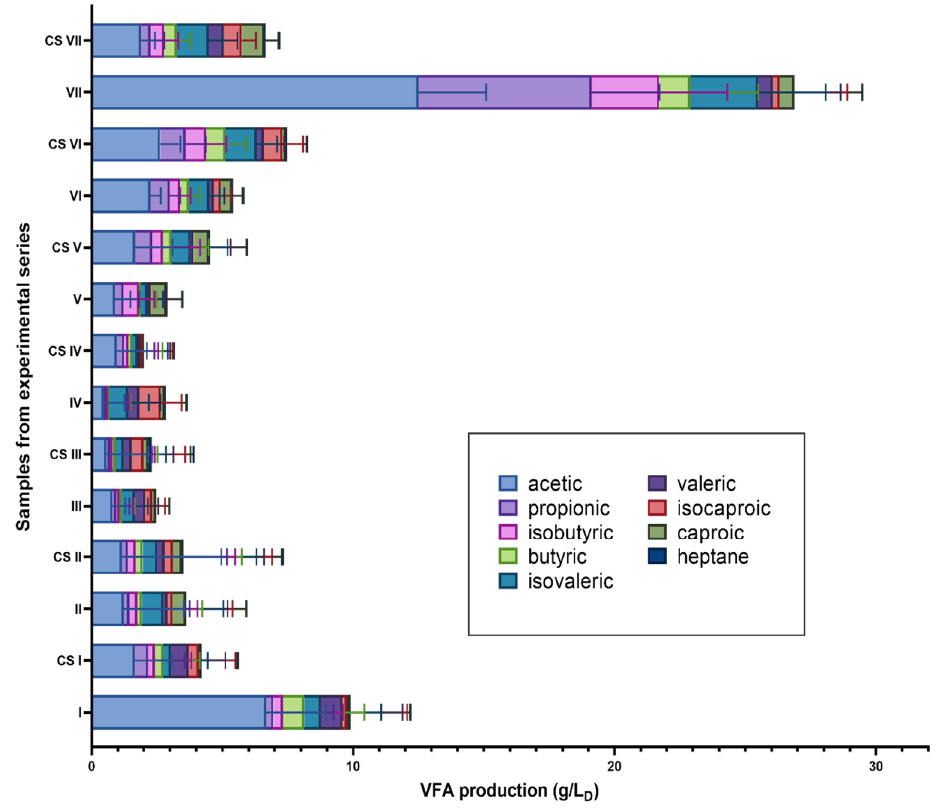
Figure 2. Average concentrations of VFAs (g/L D ± SD) in the experimental samples collected from series I–VII. Control samples without AMO, ENRO and MET are marked as CS and are labeled with the number of the corresponding experimental series (I–VII).